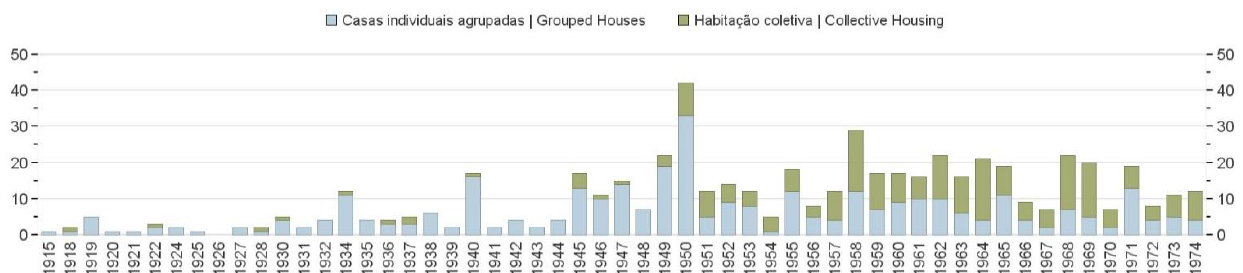
Figure A4. Linear chart. Distribution of housing descriptors per year. Source: MdH database, 2019. Universe: built estates